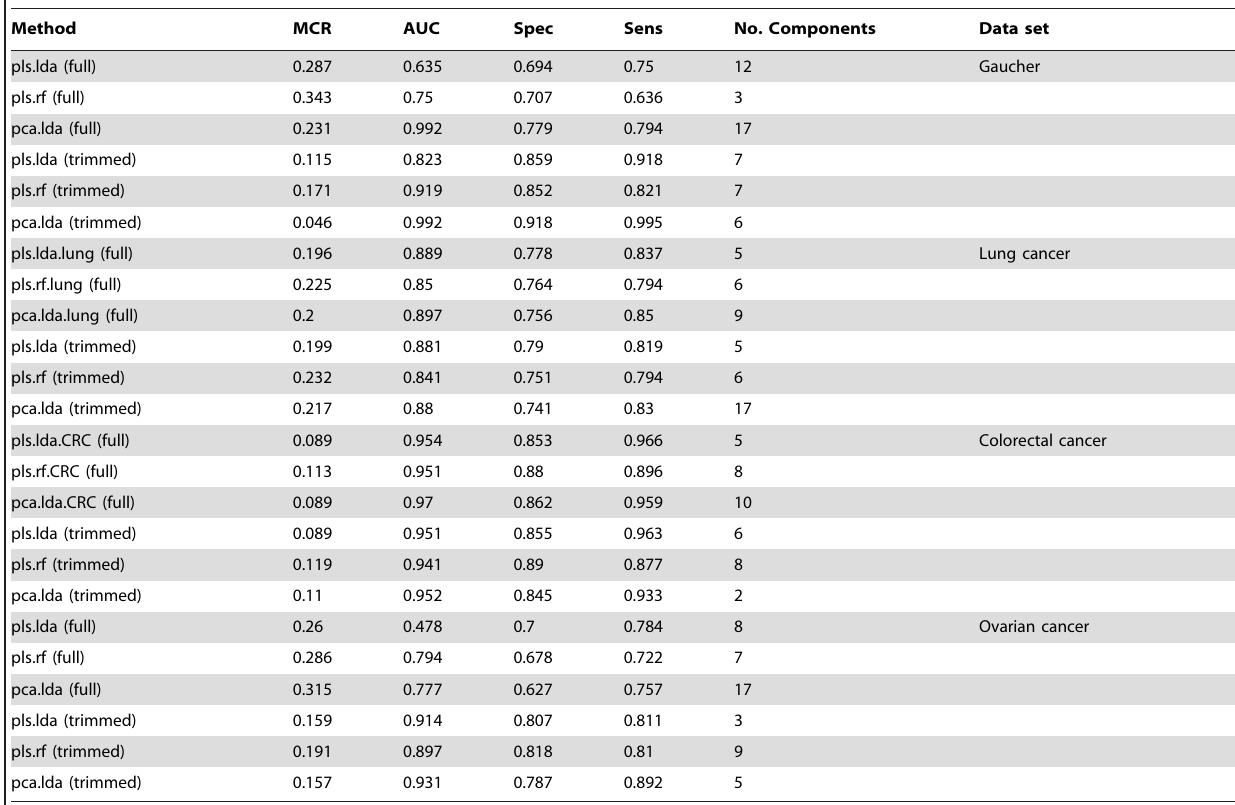
Table 1. Dimension Reduction Classifier Performance